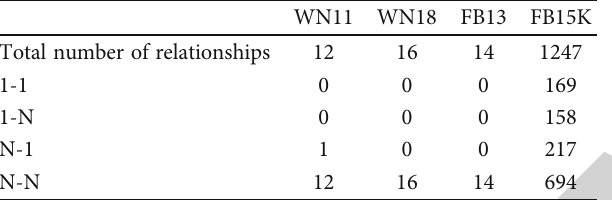
Table 2: Number of relationship types in the data set.